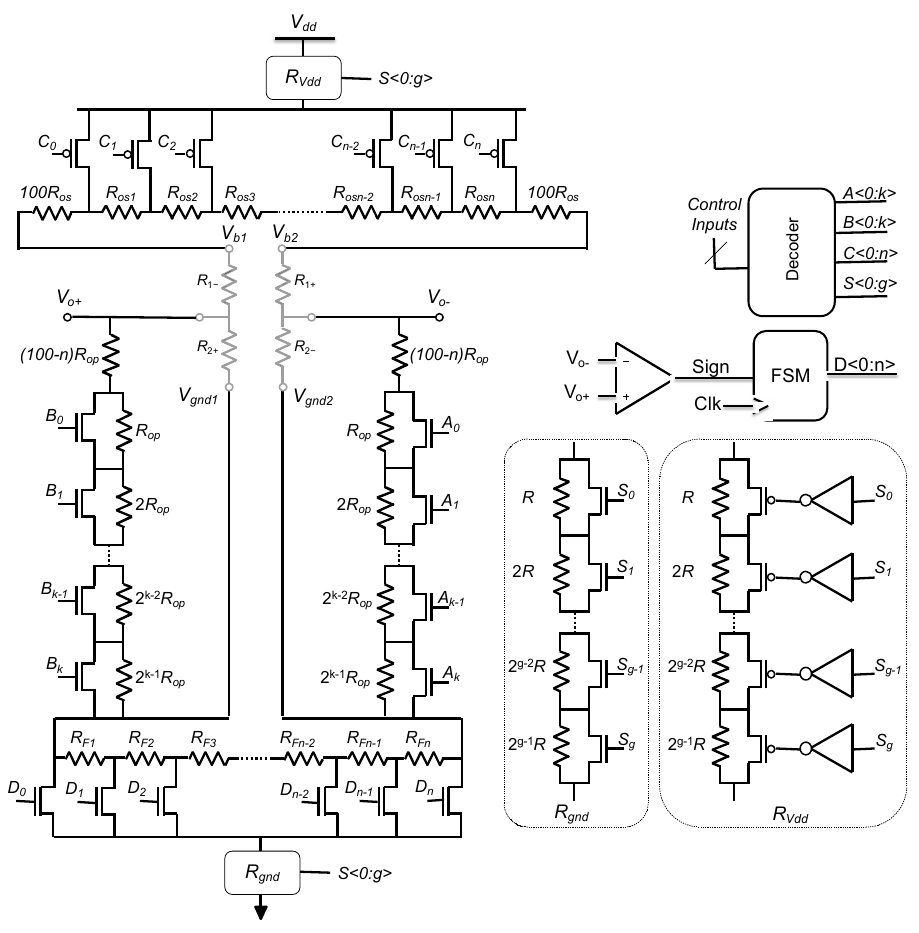
Figure 10. Complete architecture of the proposed IP for post-fabrication calibration of resistive sensors. According to (1), a sensitivity of 50 mV/% is obtained for a full bridge configuration and a supply voltage of 5 V. After offset compensation (i.e., coarse and fine tuning), the mean value of this sensitivity is reduced up to about 10% (45 mV/%) due to the presence of compensation resistances that are added in series and parallel with sensor resistors. To mimic the impact of process scattering on sensitivity, a gaussian distribution with a 10% maximal deviation of the so-obtained scale factor has been modeled. Consequently a σ of 3.33% of the mean value is observed for the scale factor. To reduce this dispersion, any value of the scale factor, lower than the minimum of the MC distribution, can be targeted.